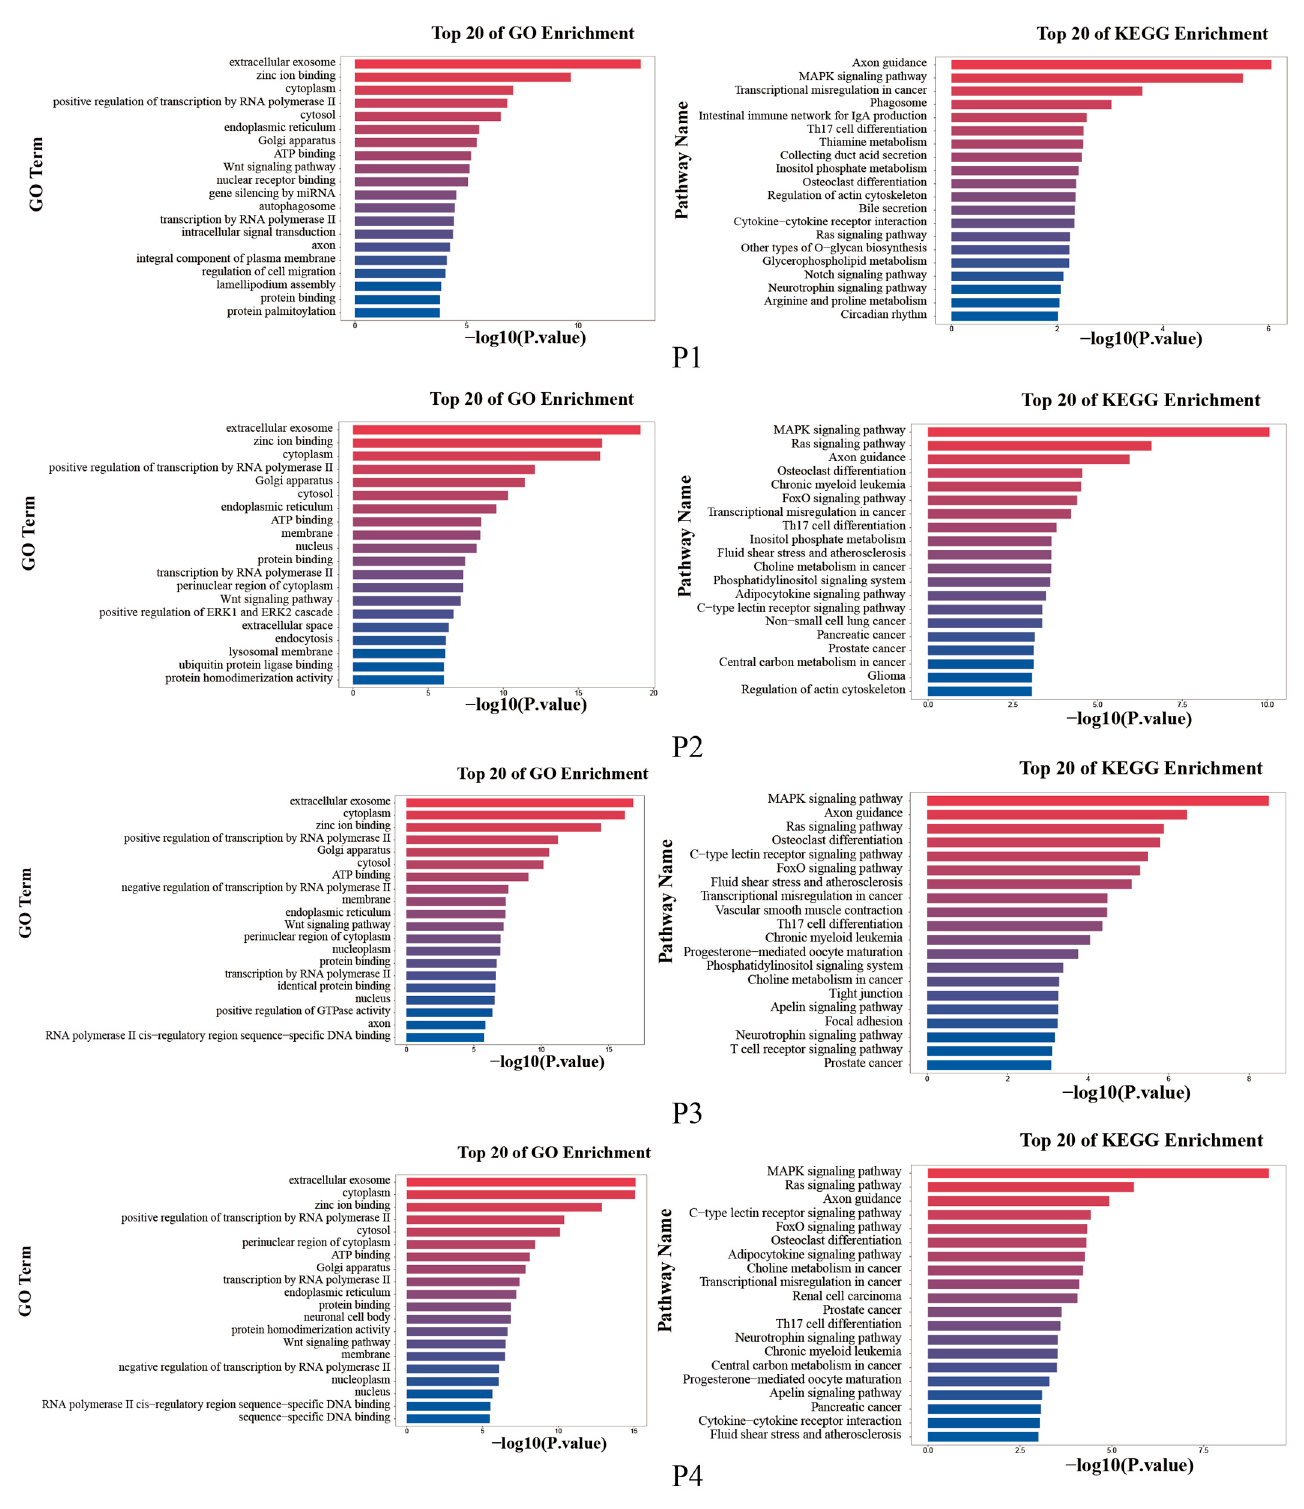
Figure 4. The top 20 enriched GO terms and KEGG pathways.